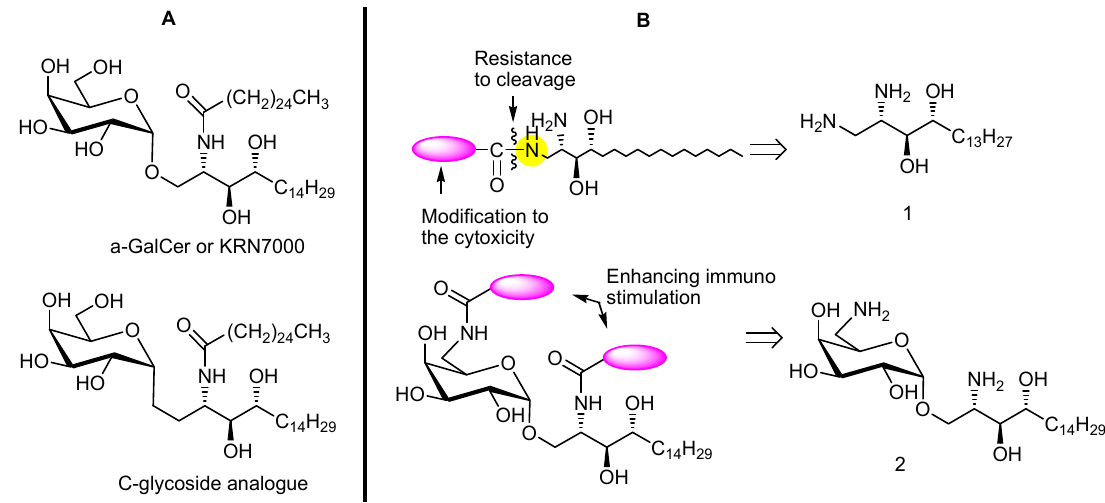
Scheme 1. Panel ( A )  -GalCer and structural analogue with stable glycosidic bond